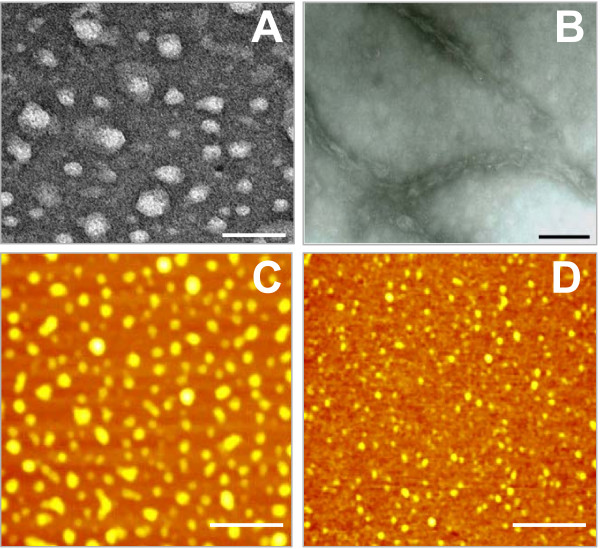
Tau deposits were imaged by transmission electron microscopy and atomic force microscopy. Tau deposits were formed by incubation of tau with formaldehyde in 100 mM sodium phosphate, pH 7.2, for one day. (A) Formaldehyde-treated tau deposits stained with uranyl acetate were observed under the electron microscope (Bar: 100 nm); (B) Tau (40 μM) was incubated with heparin (1 mg/ml) under the same conditions (Bar: 50 nm). (C) Formaldehyde-treated tau deposits observed by AFM (Bar: 125 nm). (D) Tau alone as a control was observed by AFM (Bar: 125 nm).